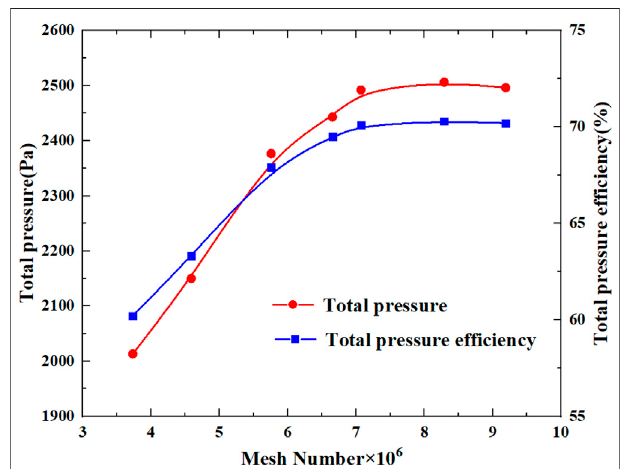
FIGURE 3 | Grid independence veri fi